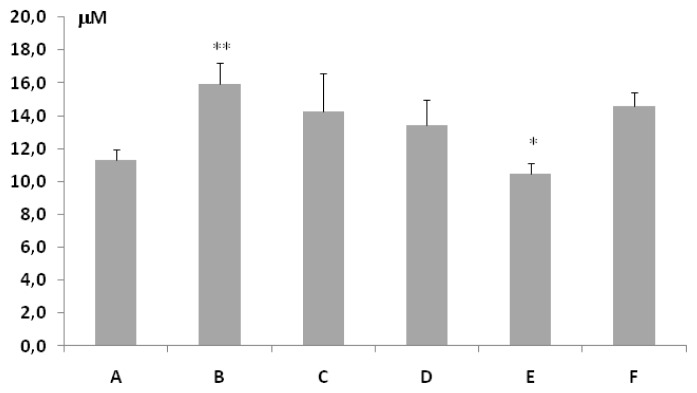
TBRAS levels in plasma, expressed as μM of malonyldialdeide, of WKY control rats (A), control SHRs (B), SHR treated with (+/−)-thioctic acid 250 μmol/kg/day (C), SHR treated with (+/−)-thioctic acid 125 μmol/kg/day (D), SHR treated with (+)-thioctic acid 125 μmol/kg/day (E), and SHR treated with (−)-thioctic acid 125 μmol/kg/day (F). ** p < 0.05 vs. WKY control rats; * p < 0.05 vs. SHR control rats.